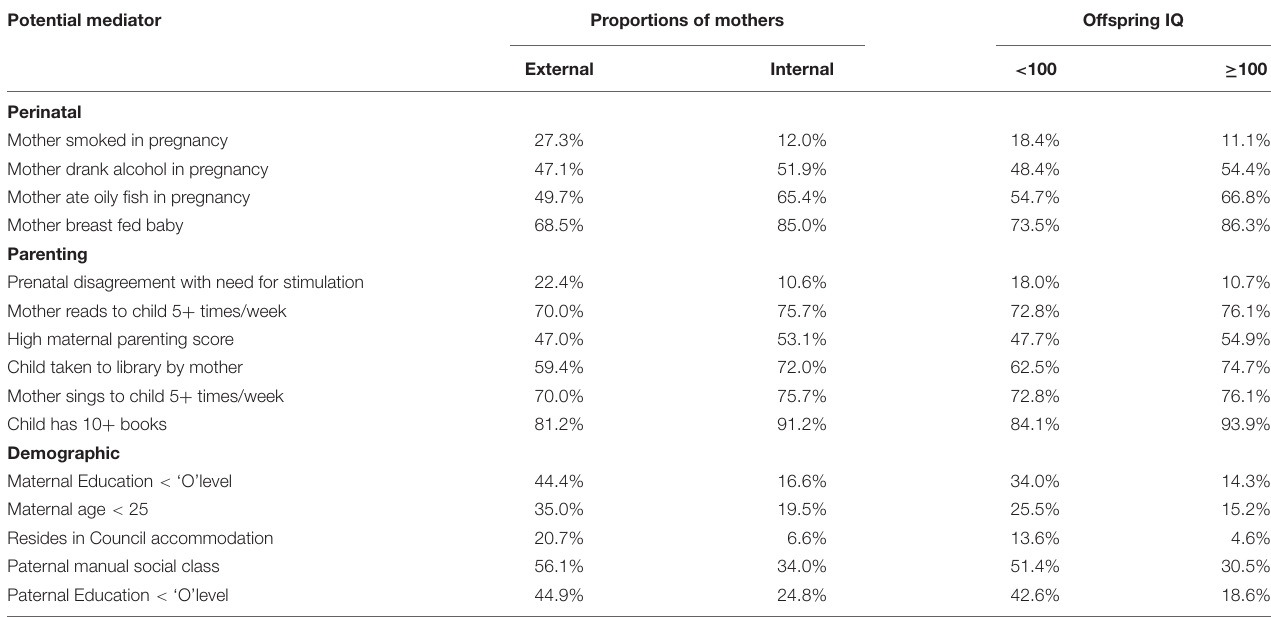
TABLE 1 | Possible mediators of offspring IQ at age 8: proportion of children with mothers in each category who are external or internal, and proportion of offspring with IQ < 100 or ≥